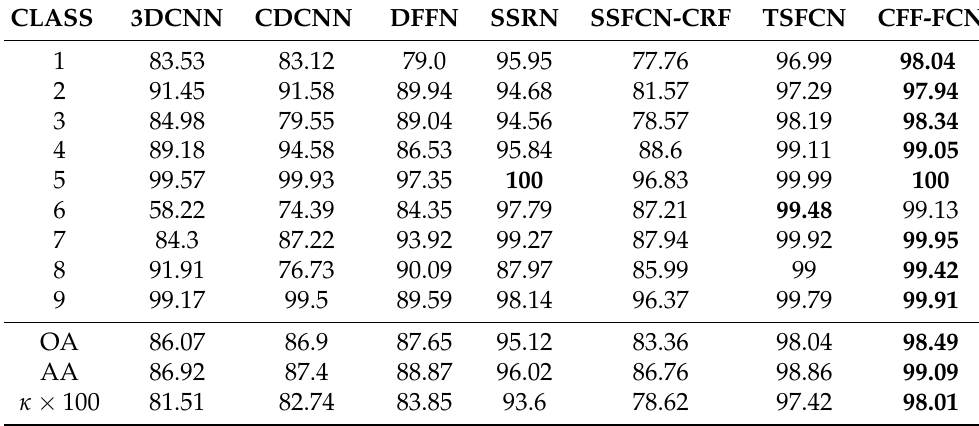
Figure 7. For University of Pavia image. ( a ) RGB composite image of three bands. ( b ) Ground-truth map. ( c ) 3DCNN. ( d ) CDCNN. ( e ) DFFN. ( f ) SSRN. ( g ) SSFCN-CRF. ( h ) TSFCN. ( i ) CFF-FCN. Table 4. Classification accuracy(%) for University of Pavia using different